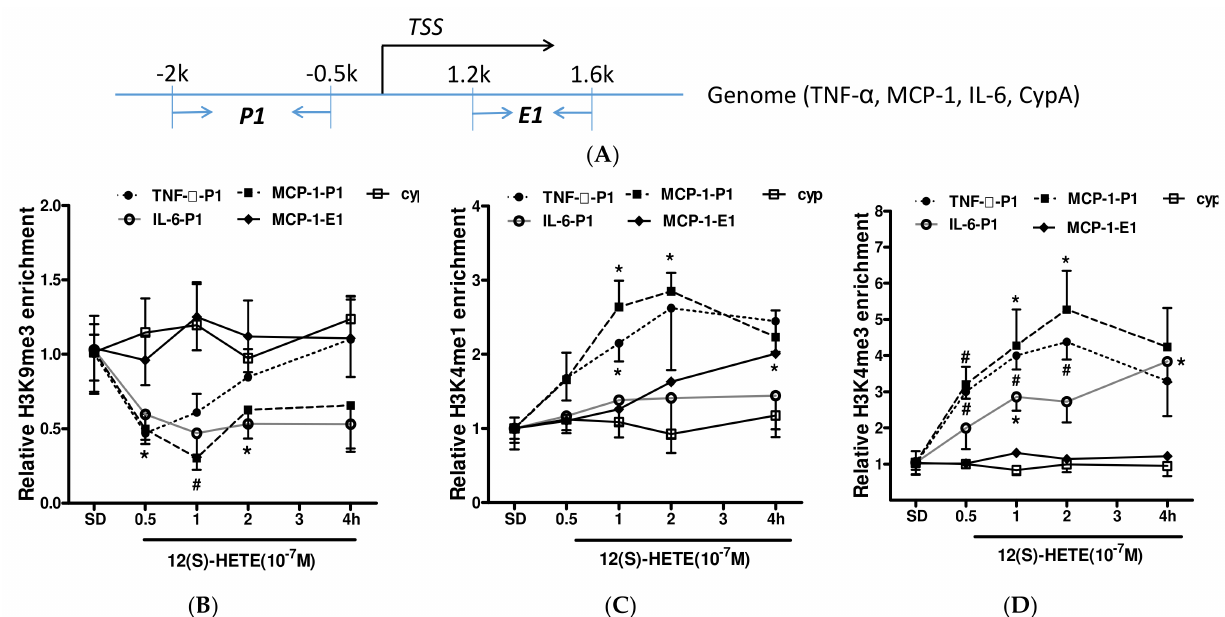
Figure 5. Treatment with 12(S)HETE induced histone modifications at inflammatory gene promoters. ( A ) Primers design for ChIP assay located at gene promoter (P1) or enhancer (E1) region close to transcription start site (TSS). Quiescent MMCs were treated with 12(S)HETE (10 − 7 M) for 2 h,